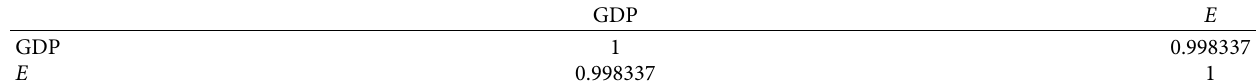
Figure 8: Scatter plot and fitting regression line of fiscal expenditure and GDP. Table 2: The correlation coefficient between fiscal expenditure and